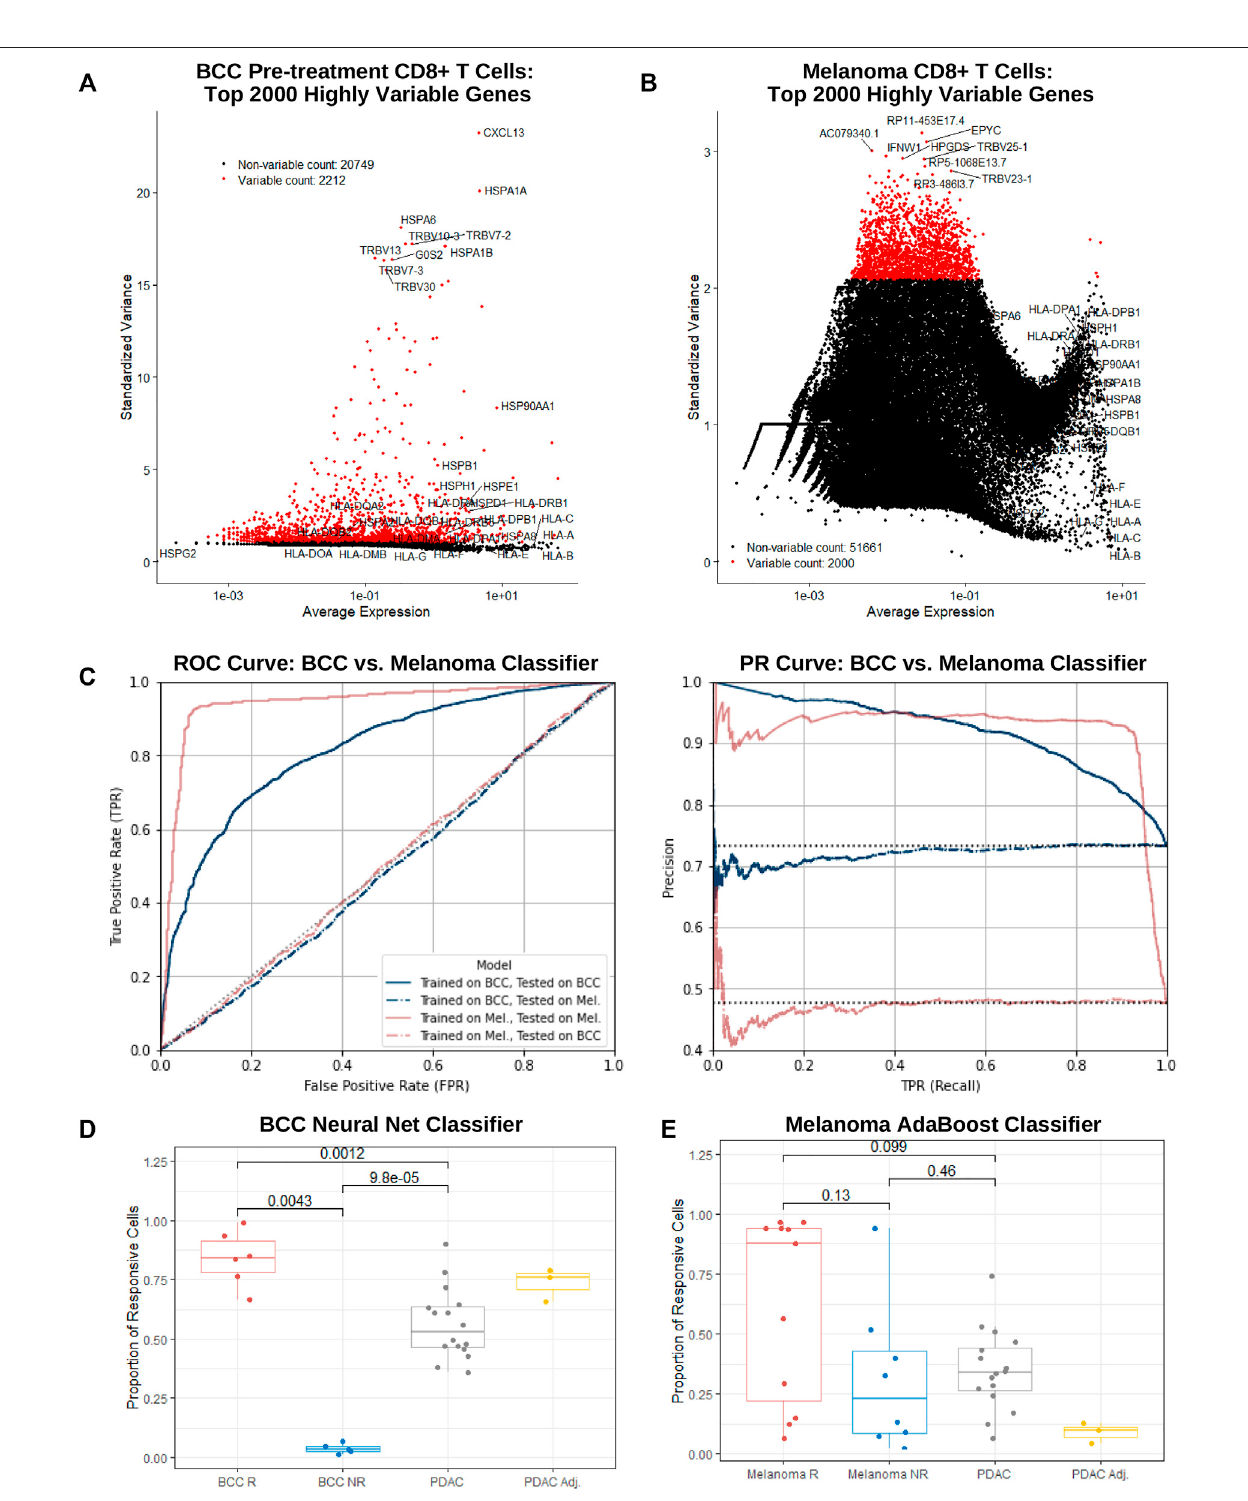
FIGURE 4 | BCC, PDAC, and melanoma exhibit different immune mechanisms in response to PD-1 blockade. (A,B) Dot plot of average gene expression vs standardized variance of all CD8 + T cells in (A) BCC pre-treatment and (B) melanoma samples. (C) ROC and PR curve of a neural net (MLP) and AdaBoost classi fi er trainedonthetop2000highlyvariablegenesinBCCandmelanomaCD8 + Tcellsrespectively;bothmodelsweresubsequentlytestedoneachdatasetseparately. (D,E) Proportion of CD8 + T cells classi fi ed as responsive to PD-1 blockade per patient by the (D) BCC neural net and (E) melanoma AdaBoost classi fi er.